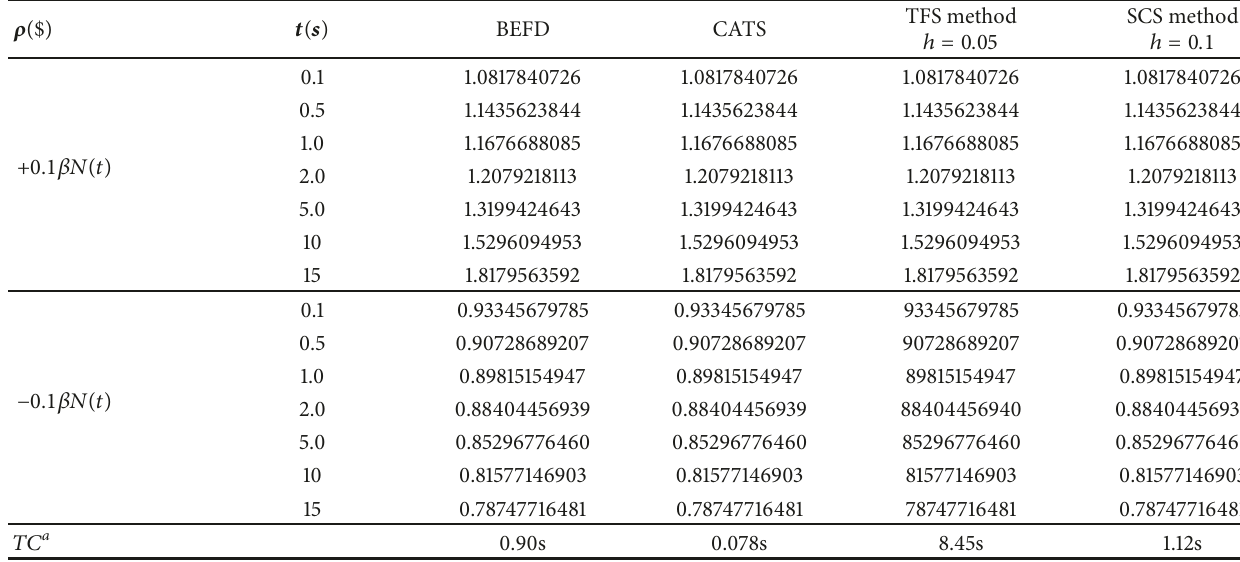
Table 5: Comparison between the SCS method versus the highly accurate numerical methods: BEFD, CATS, and TFS methods for the case when the reactivity is a function of neutron